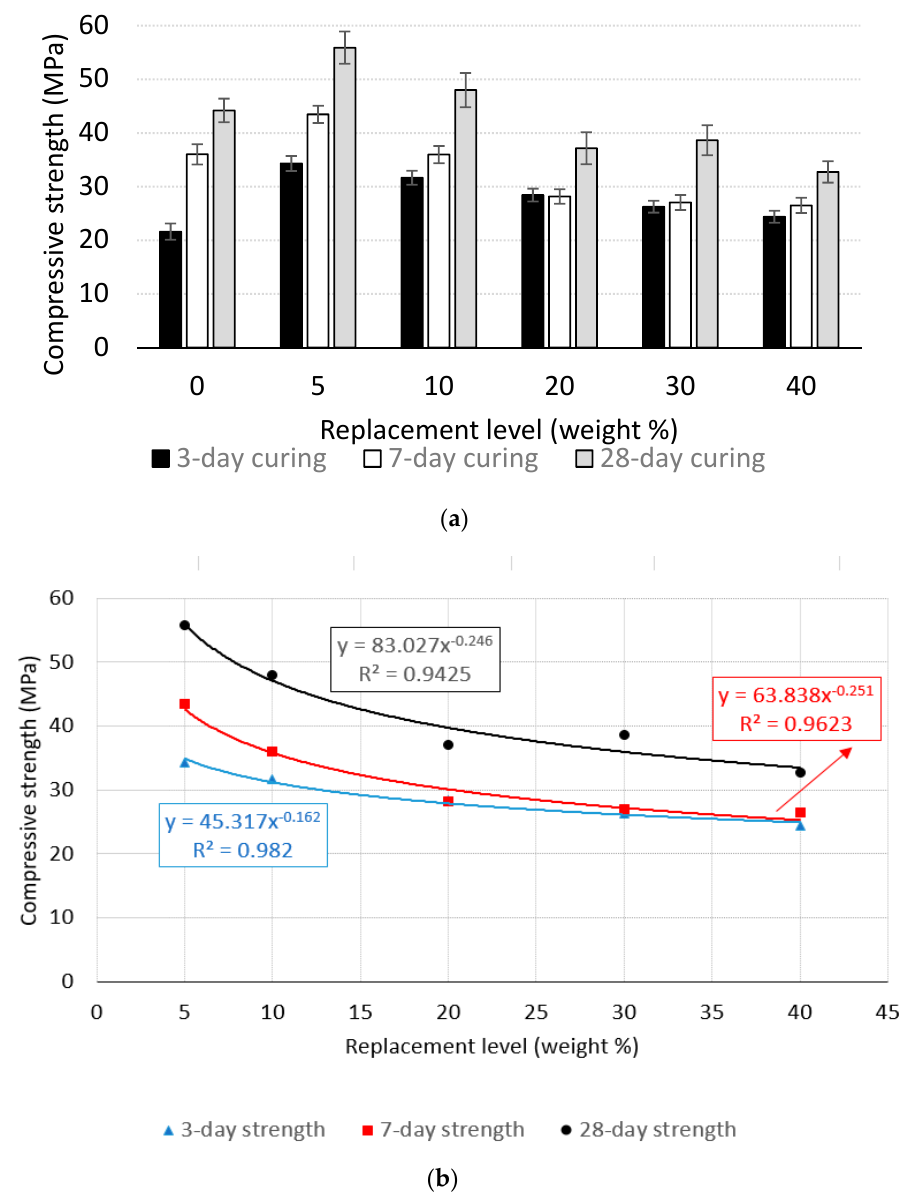
Figure 5. Compressive strength development for mortar with different replacement ratios; ( a ) experimental results, ( b ) best fit curves.